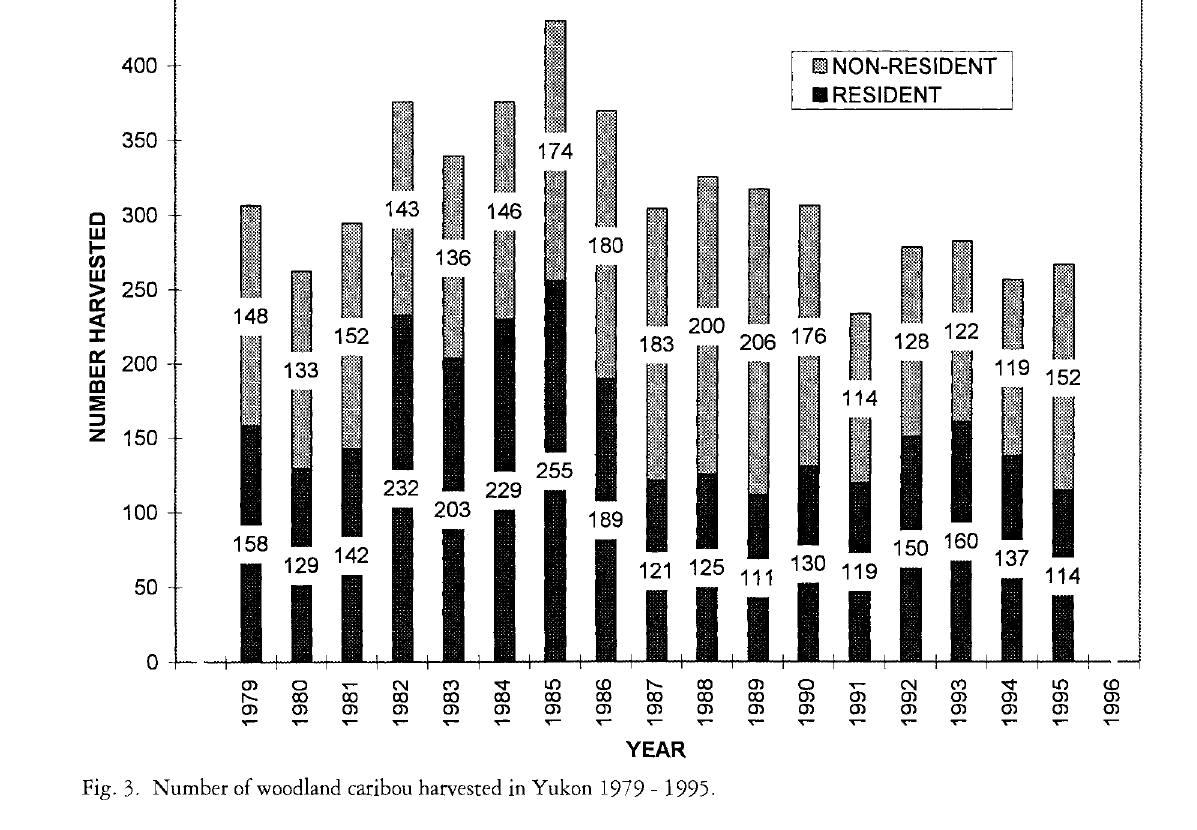
Fig. 3. Number of woodland caribou harvested in Yukon 1979 -